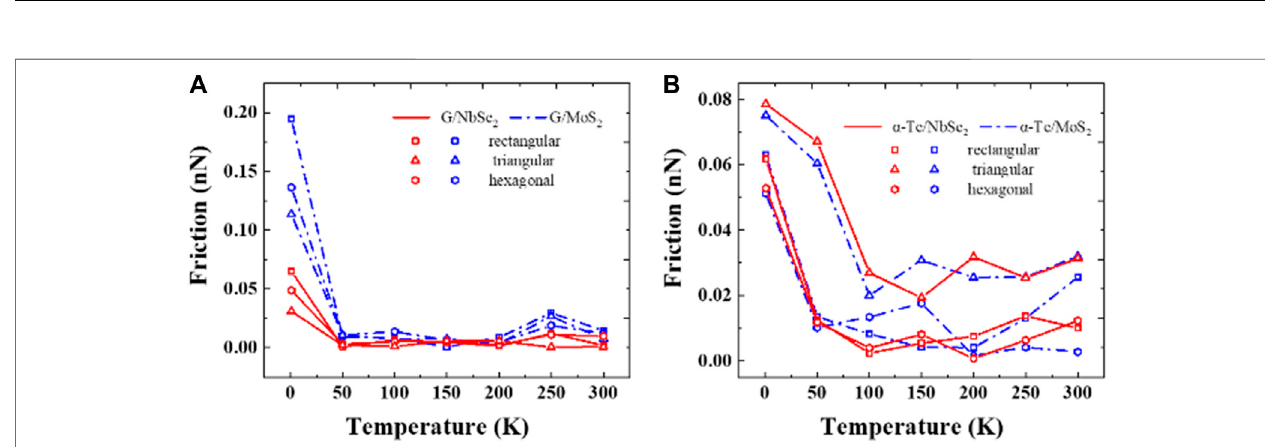
FIGURE12| Effect oftemperature ontheinterlayerfriction. Theshapeofthedatapointsrepresentstheshapeofthesliderinthesimulation,whichare rectangular, triangular, and hexagonal. (A) graphene/MoS 2 and graphene/NbSe 2 heterostructures; (B) α -Te/MoS 2 and α -Te/NbSe 2 heterostructures.